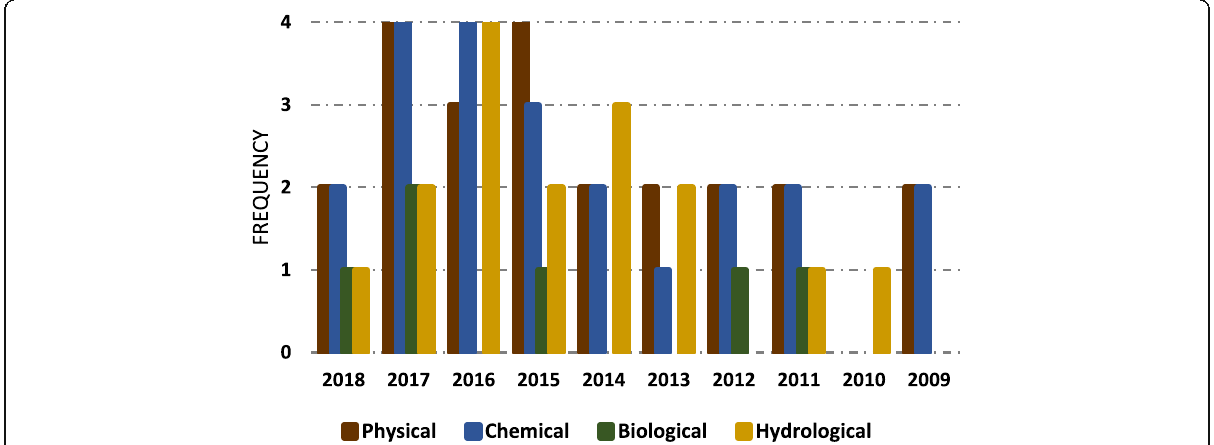
Fig. 4 Frequency of water quality parameters used in different studies in Malaysia